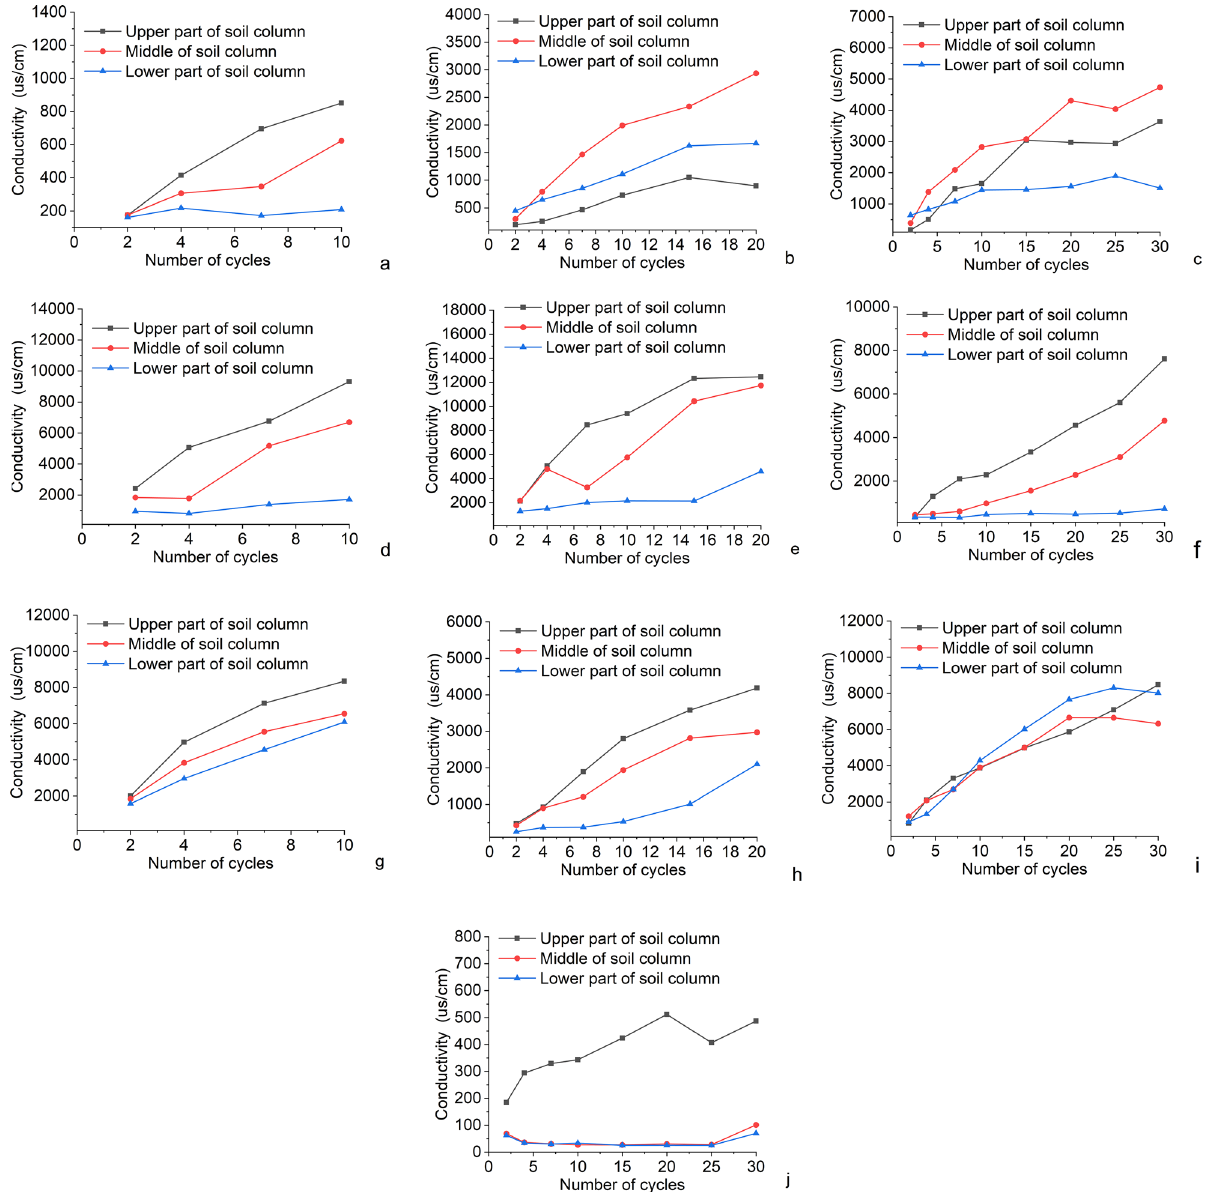
Figure 7. Conductivity change of each soil column ( a ) Experimental group:1; ( b ) Experimental group 2; ( c ) Experimental group 3; ( d ) Experimental group 4; ( e ) Experimental group 5; ( f ) Experimental group 6; ( g ) Experimental group 7; ( h ) Experimental group 8; ( i ) Experimental group 9; ( j ) Experimental group